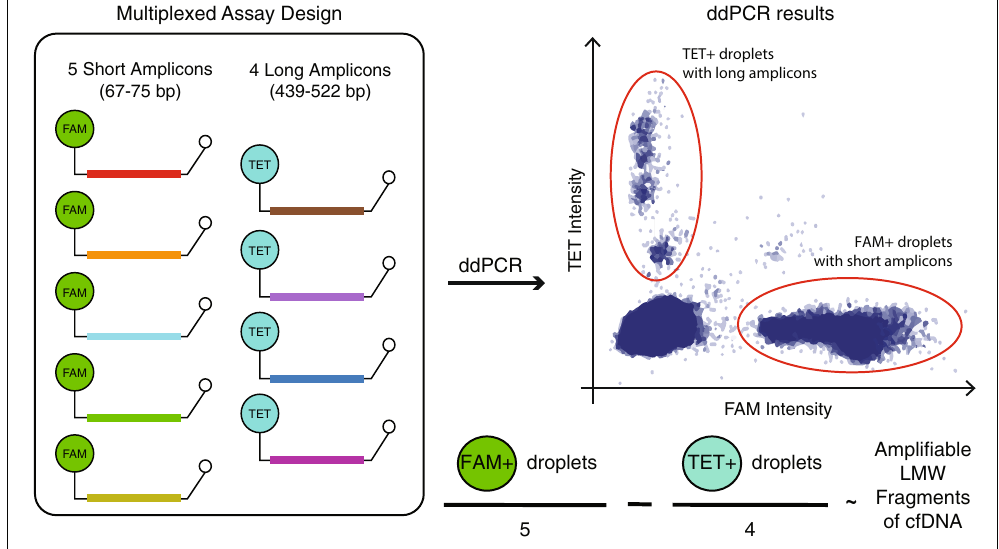
Figure 1. Schematic representation of a multiplexed droplet digital PCR approach for measuring cfDNA quantity and evaluating fragment size. We expect two populations of droplets with distinct fluorescence, each representing the sum of products from the two amplicon sets. The number of FAM-positive droplets represents 5 times the number of haploid genome equivalents (GEs) with fragments long enough to be amplified using short amplicons. Similarly, the number of TET-positive droplets represents 4 times the GEs with fragment sizes amplifiable using long amplicons. We calculate low molecular weight (LMW) cfDNA concentration as the difference between average short and long GEs. Primer sequences and amplicon sizes are listed in Supplemental Table 1 and amplicon positions relative to common SNPs are shown in Supplemental Figure